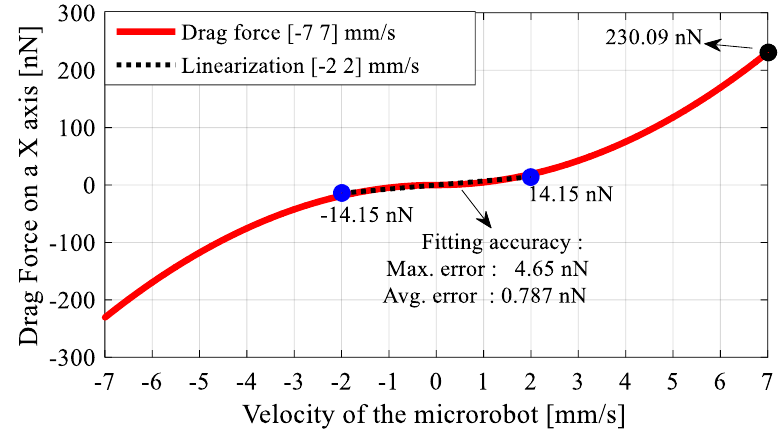
Figure 5. Exhibits a parabolic drag force characteristic depending on the velocity of micro-UFO. The drag force change is less for the [ − 2, 2] mm/s range, which is the microrobot motion speed. For this reason, the system can be expressed by linear equation, by performing curve fitting at the specified interval. For the equation proposed as F d = kV r , a constant coefficient was found to be k = 7.075 × 10 − 9 kg/s 2 . Due to the symmetric structure of the microrobot, the force calculation is preferably shown only for x -axis.